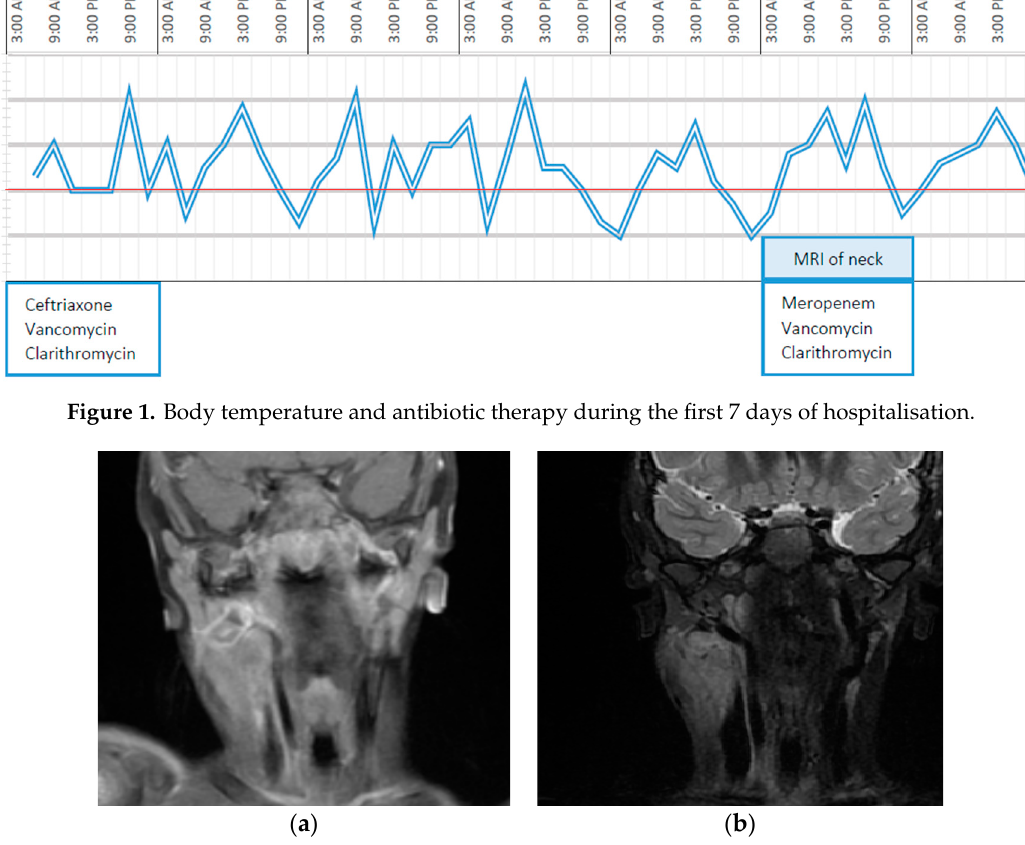
Figure 2. Magnetic resonance imaging (MRI) of the neck. ( a ): Right anterolateral multiple polycyclic lymph nodes with ill-defined contours and tendency to confluence. Intense enhancement of the adjacent sternocleidomastoid. Displacement of the vascular bundle of the neck and internal jugular vein compression. ( b ): Enhancement of parapharyngeal and retropharyngeal tissues without fluid collection and with preserved respiratory space. Multiple bilateral enlarged lymph nodes in parapharyngeal and retropharyngeal space. Minimum contrast enhancement of the atlantoaxial joint.